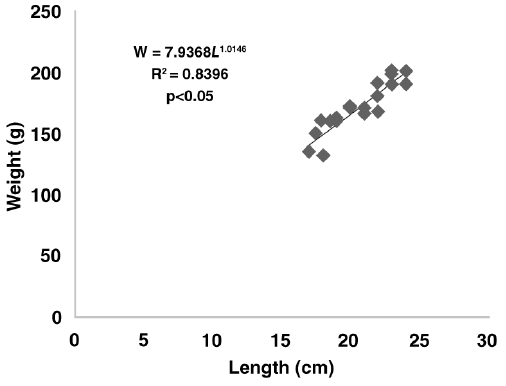
The FCE for giant gourami culture is 0.77 (1.0 kg feed fish results in 0.77 kg of fish). This value suggests that the waste load is 0.23 kg (1.0 kg feed – 0.77 kg fish). The above calculation can be applied to other species. FCR, feed conversion rate; FCE, feed conversion efficiency.